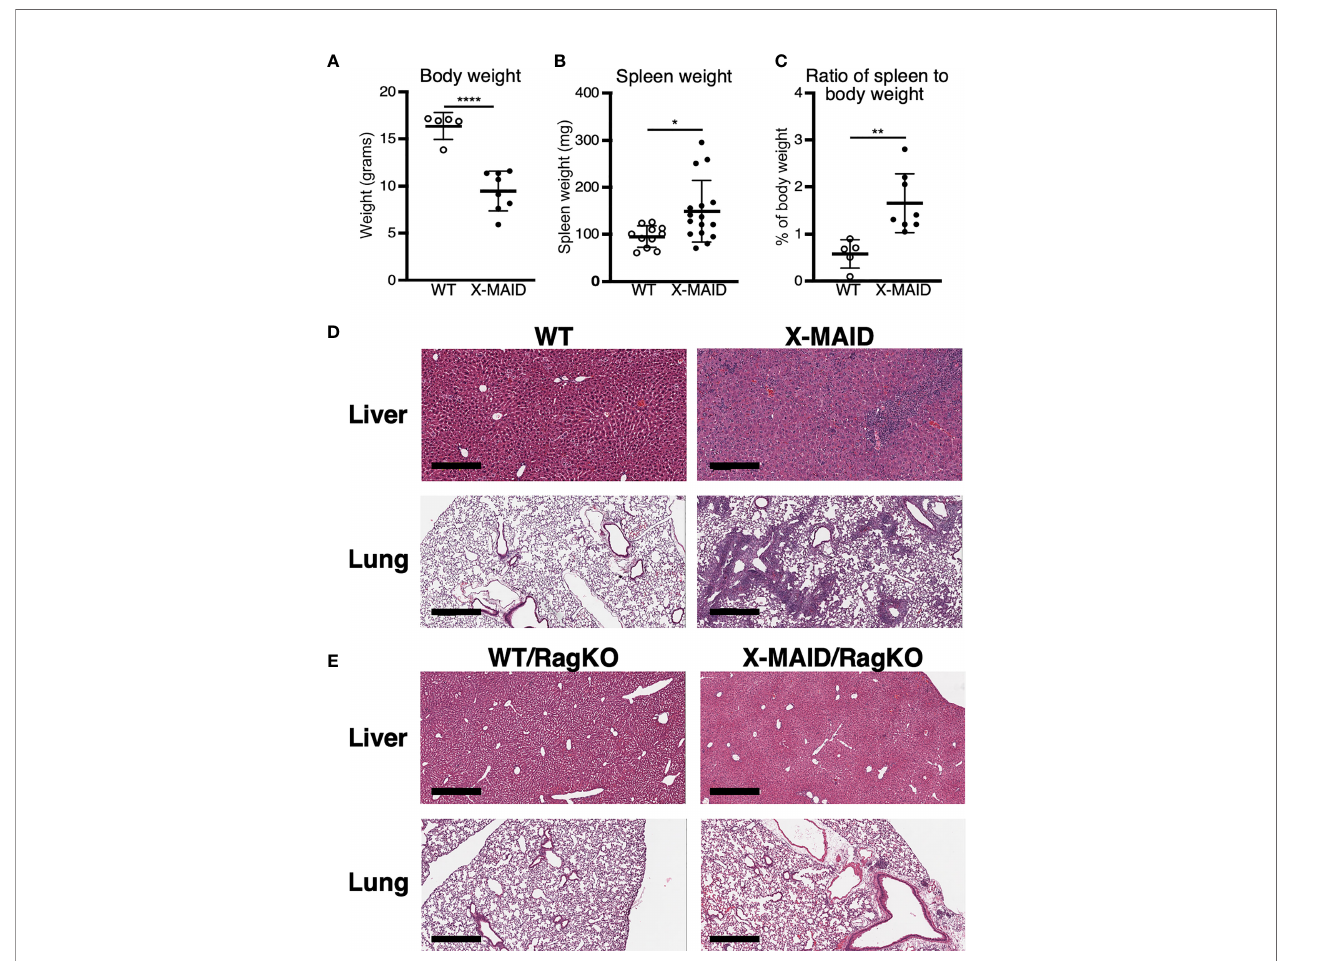
FIGURE 1 | X-MAID mice exhibit systemic in fl ammation ameliorated by lymphocyte deletion. WT or X-MAID male mice at 3-4 weeks old were measured for (A) body weight and (B) spleen weight. (C) The ratio of spleen to body weight was calculated. (D, E) H&E stains of sections from liver and lung of the indicated mouse strains, all at 3-4 weeks of age. Scale bars = 600 m m. Note the granulocytic in fi ltration in X-MAID tissues, which is absent in tissues from X-MAID/RagKO mice. Data in (A – C) represent means ± StDev, with each point representing an individual mouse. Statistics were calculated using a Student ’ s t test, *p < 0.05, **p < 0.01, ****p <